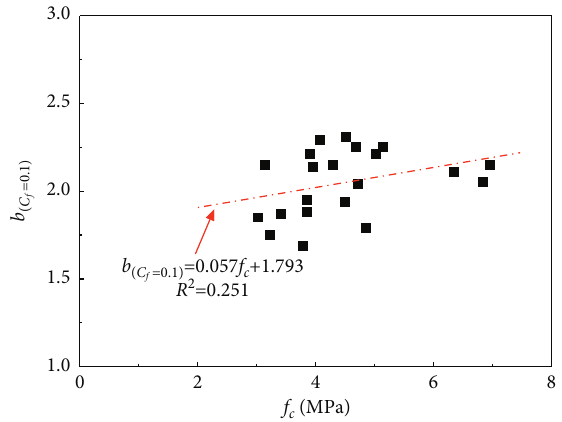
Figure 22: Relations between parameter b and f